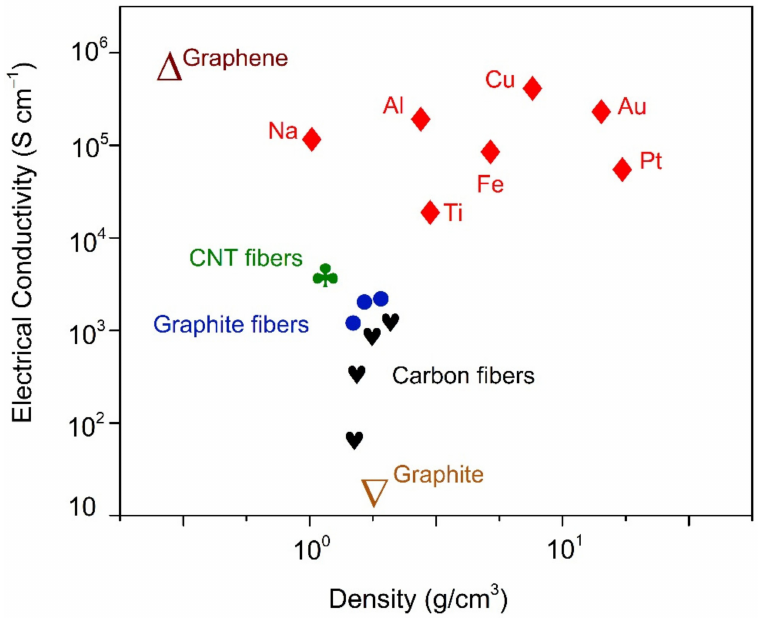
Figure 6. Electrical conductivity of materials [67] (p.